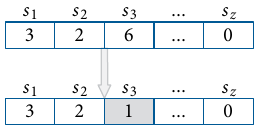
Figure 3: An instance of mutation